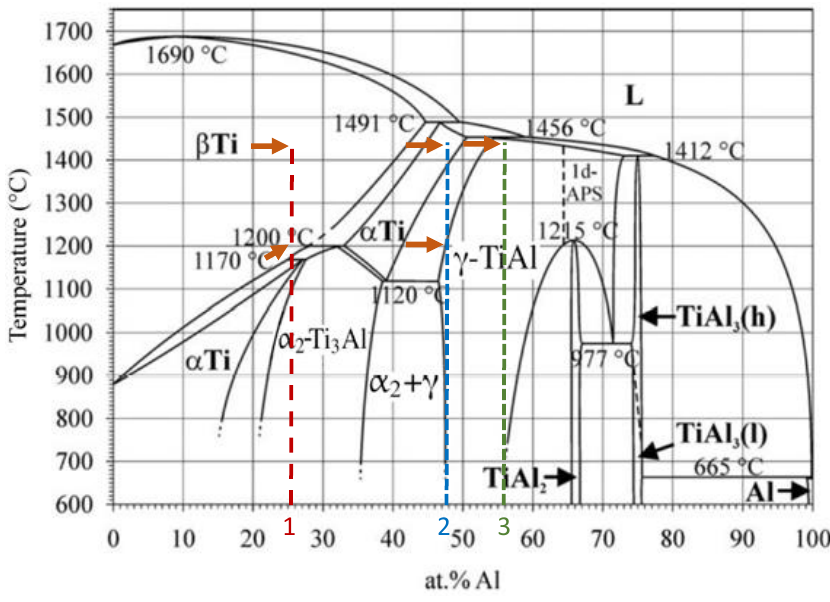
Figure 1. Phase diagram of Ti – Al. Reproduced with permission from Zambaldi, C.R. et al. [17].